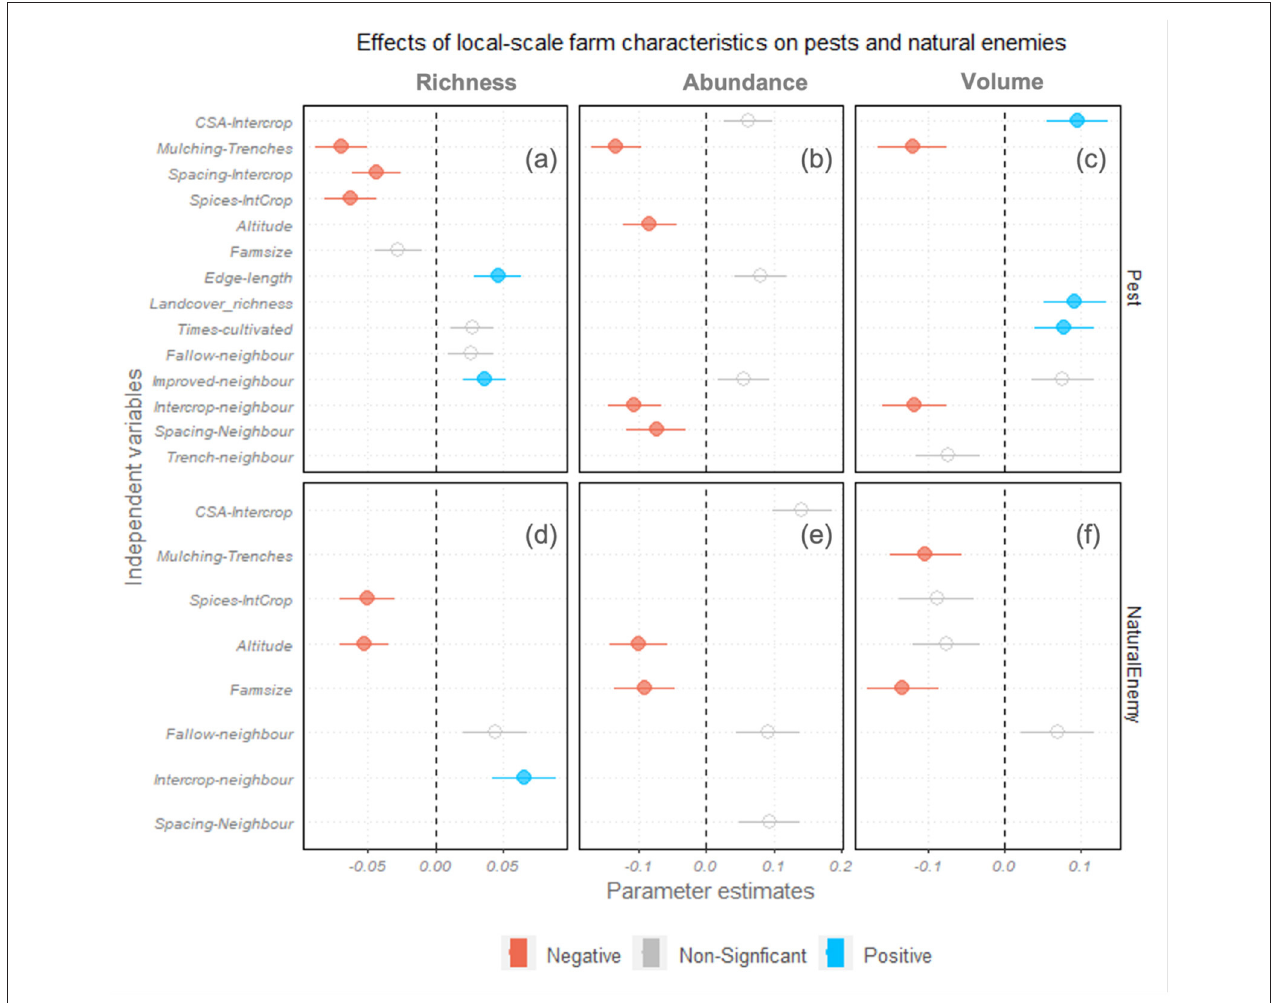
FIGURE 4 | The coefficient plot of richness (a,d) , abundance (b,e) and volume (c,f) of pests (a–c) and natural enemies (d–f) (3 × 2 models) in response to farm clusters based on management practices, neighbouring field characteristics, and landscape context. The independent variables selected in the best fit model ( 1 AIC < 2) are shown. Each panel represents a different model. The positions of the circles represent β -coefficients, horizontal lines on the circles show SE, and colors signify the direction of the